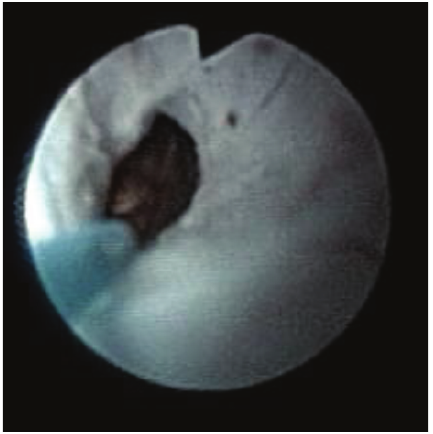
Figure 2: Ureteral meatus catheterization.